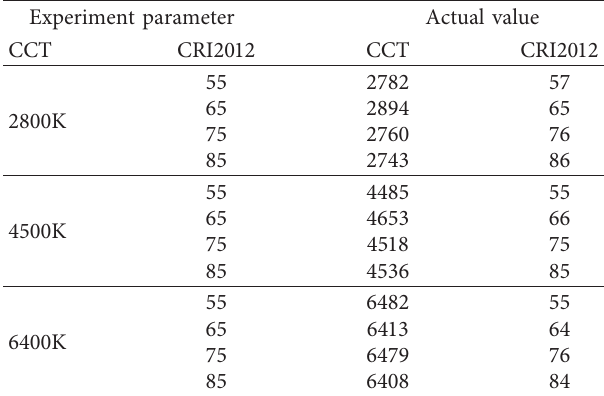
Figure 1: Relative SPDs of LEDs with different CRI2012s and CCTs, measured by Spectrometer I1-pro. Table 1: Simulated real parameters of 12 lighting conditions in the